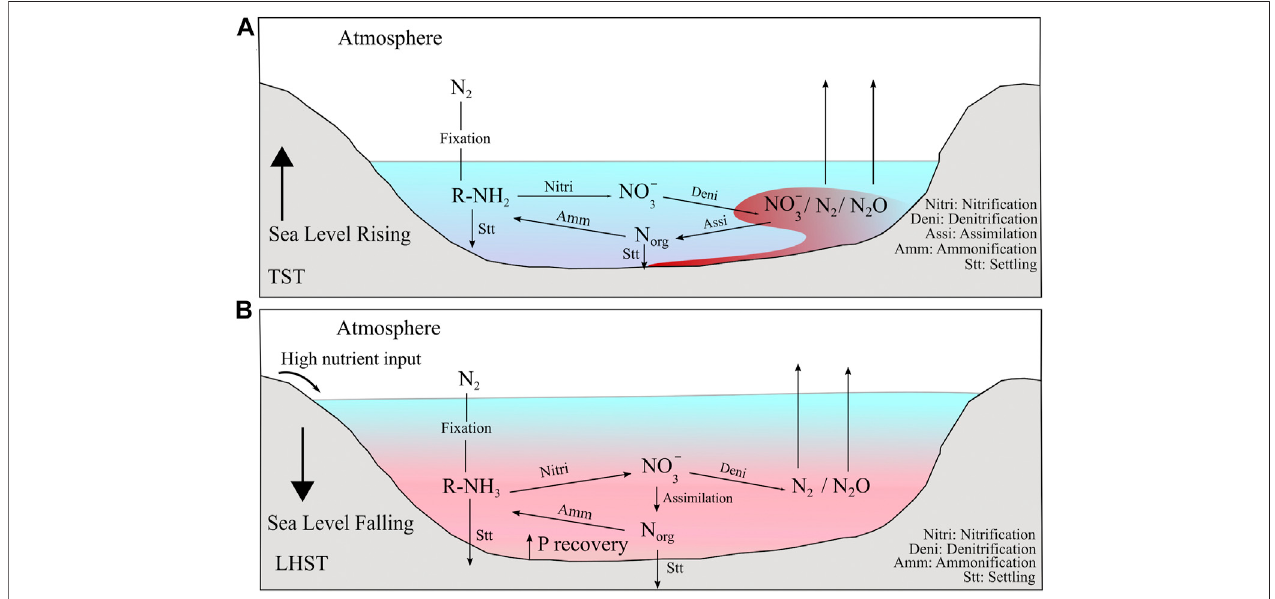
FIGURE 10 | Possible scenario of the N-cycle on the Bambuí Basin during the deposition of its basal sequences. (A) During the TST, a stable nitrate pool was established and the most dominant form of N available was nitrate that went through partial denitri fi cation on zones of low oxygenation. (B) During the LHST, the high inputofnutrients comingfromthecontinentandPrecoveryunderanoxicbottom waterconditions,causedthelimitationofNO 3 − insuper fi cialwaters,makingN 2 fi xation the main form of N acquisition by phytoplankton.